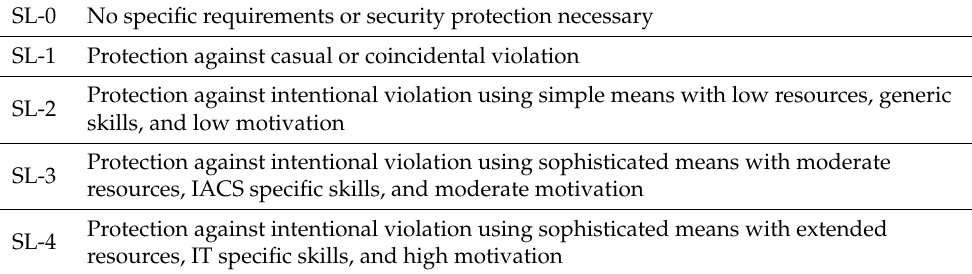
Table 2. Cyber SL